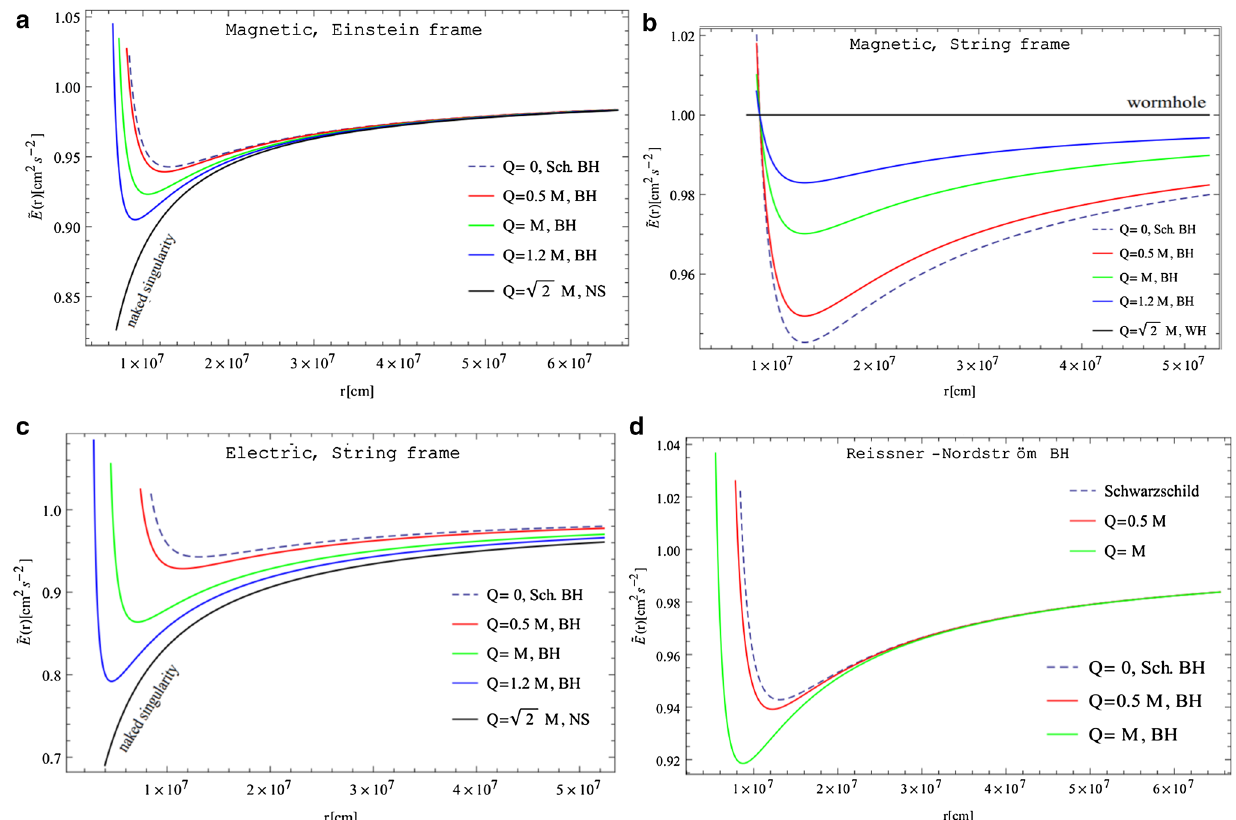
Fig. 3 The specific energy ˜ E ( r ) of the orbiting particles as a function of the radial coordinate r (in cm) for a GMGHS BH in EF ( a ), mag- netically charged in the SF ( b ), electrically charged in the SF ( c ) and Reissner–Nordström BH ( d ) plotted for different values of Q . We see